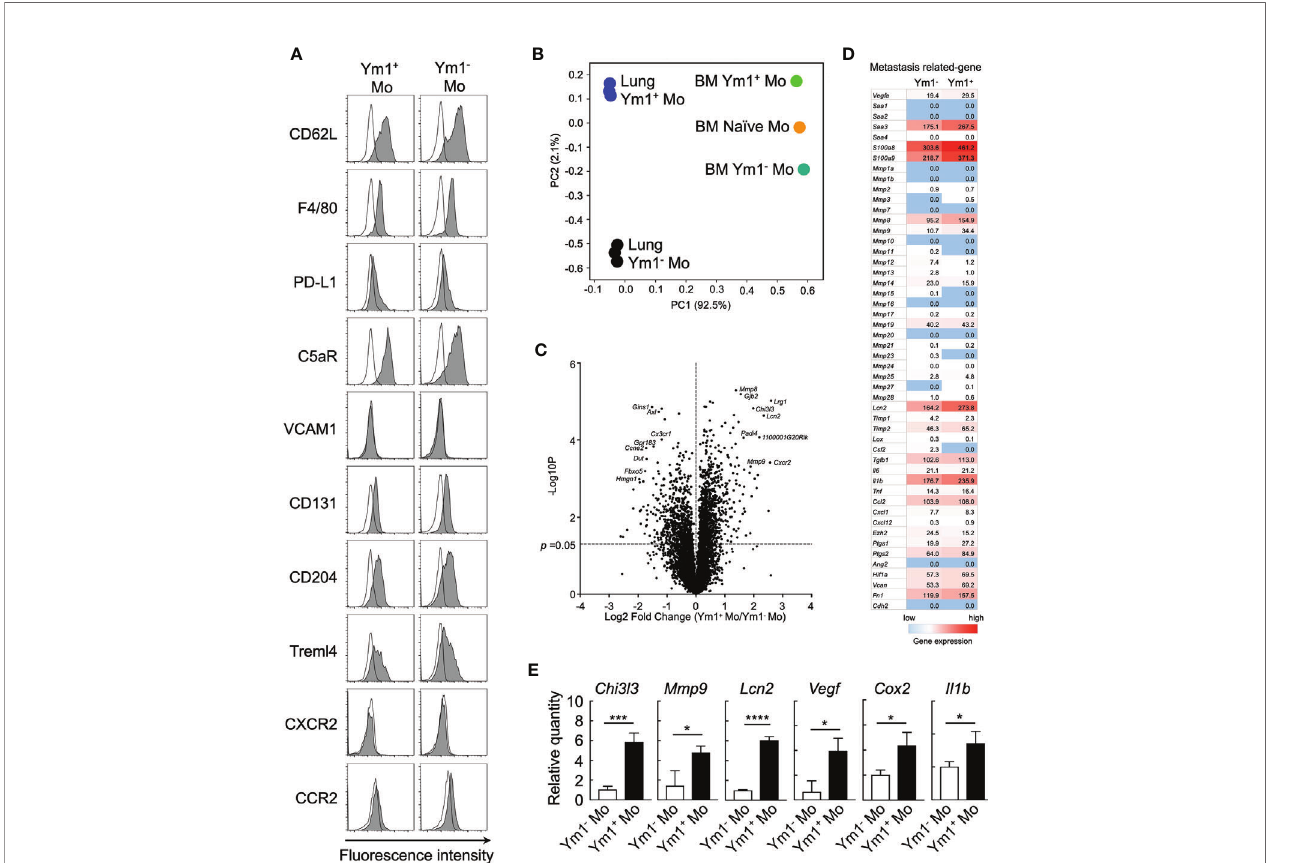
FIGURE 3 | Ym1-Venus + Ly6C hi monocyte express metastasis-related genes. (A) Ym1-Venus mice were injected intravenously with LPS (20 µg). Forty-eight hours later, the expression of surface markers of Ym1 + Mo and Ym1 - Mo in lung was analyzed by fl ow cytometry. Black lines indicate isotype control. (B, D) Gene expression pro fi les of Ym1 + Mo or Ym1 − Mo in lung and BM were globally compared by RNA-sequencing analysis. PCA (B) , volcano plots (C) , and heatmap of indicated genes (D) . (E) mRNA expression levels in Ym1 + Mo and Ym1 - Mo of lung. Ym1-Venus mice were injected intravenously with LPS (20 µg) followed by i.v. injection of B16 cells (1 x 10 5 cells) 6 h later. Ym1 + Mo and Ym1 - Mo were sorted from BM of Ym1-Venus mice 48 h after LPS treatment. the expression of mRNA levels was analyzed. Average values are shown with SD. Unpaired two-tailed t-test, n = 3. ****P < 0.001; ***P < 0.005, *P <